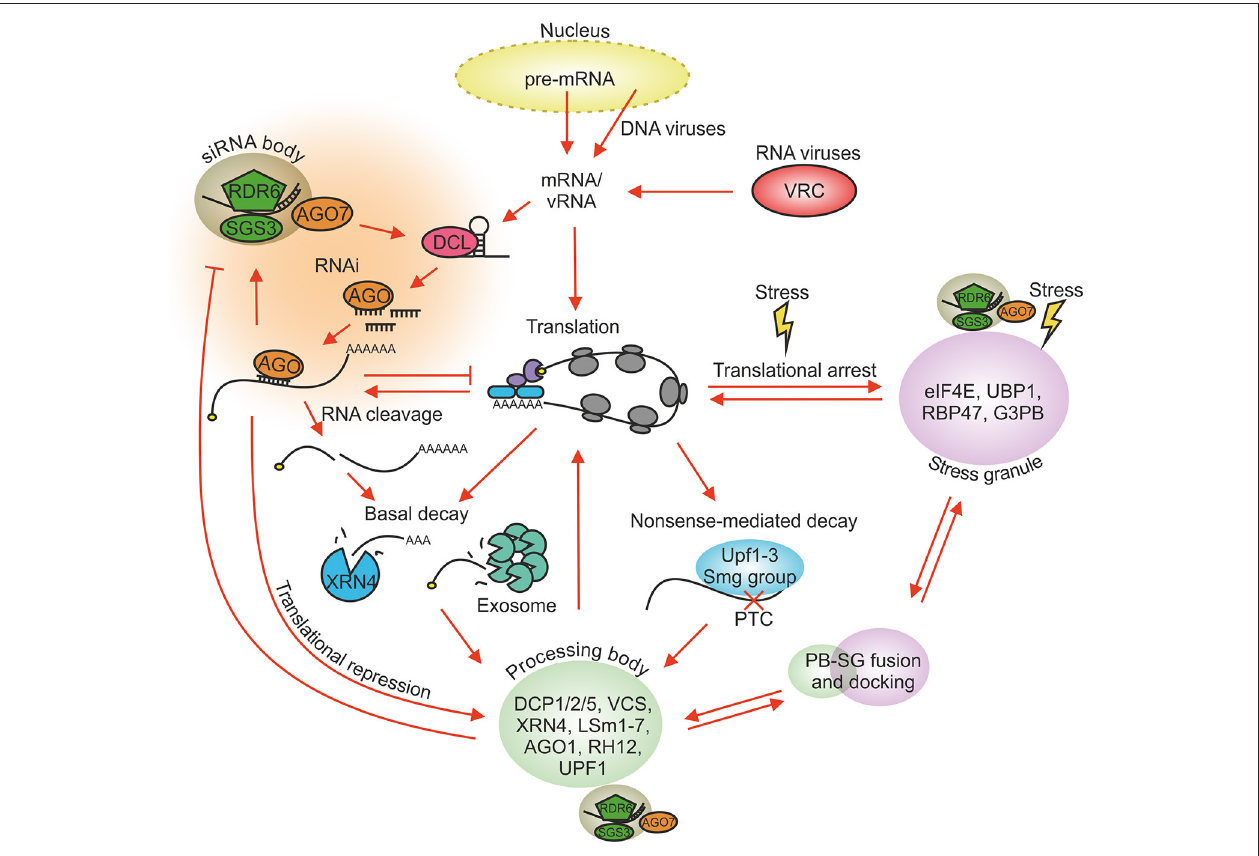
FIGURE 1 | Major RNA regulatory processes in plant cells. Host mRNAs carrying the 5 ′ cap and the 3 ′ poly(A) tail are recruited to ribosomes for translation. vRNAs have evolved means to regulate host translation for their benefit. Various cellular stresses create SGs and increase the size and number of PBs. Translationally stalled pre-initiation complexes condense into SGs and can be released back to translation when stress conditions disappear. RNAs lacking the 5 ′ cap and the 3 ′ poly(A) tail are targeted for decay whereas translationally repressed RNAs can be redirected from PBs back to translation. PBs and SGs dock, fuse and exchange material. vRNAs and mRNAs recognized by the RNA silencing and NMD machineries are targeted for degradation. The RNA silencing functions are partially located to siRNA bodies and NMD to PBs. siRNA bodies can associate with PBs and SGs during stress. Only the main components of each granule type are shown. PB, processing body; SG, stress granule; NMD, nonsense-mediated decay; PTC, premature termination codon; VRC, virus replication